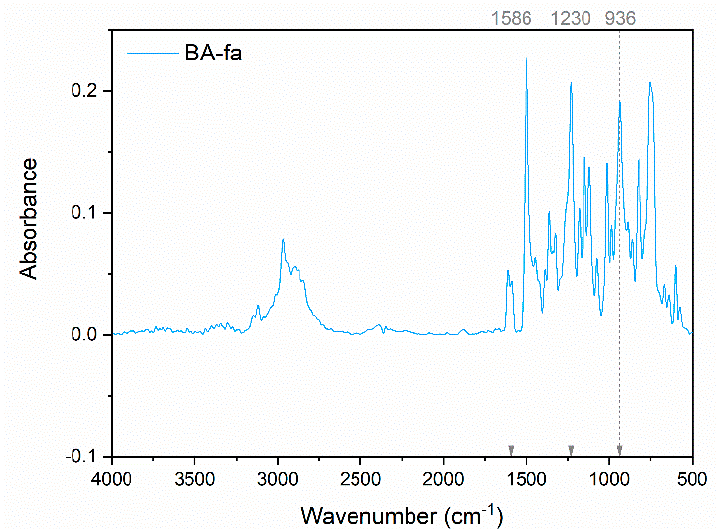
Figure A34. 13 C NMR spectrum in CDCl 3 of BA-fa.